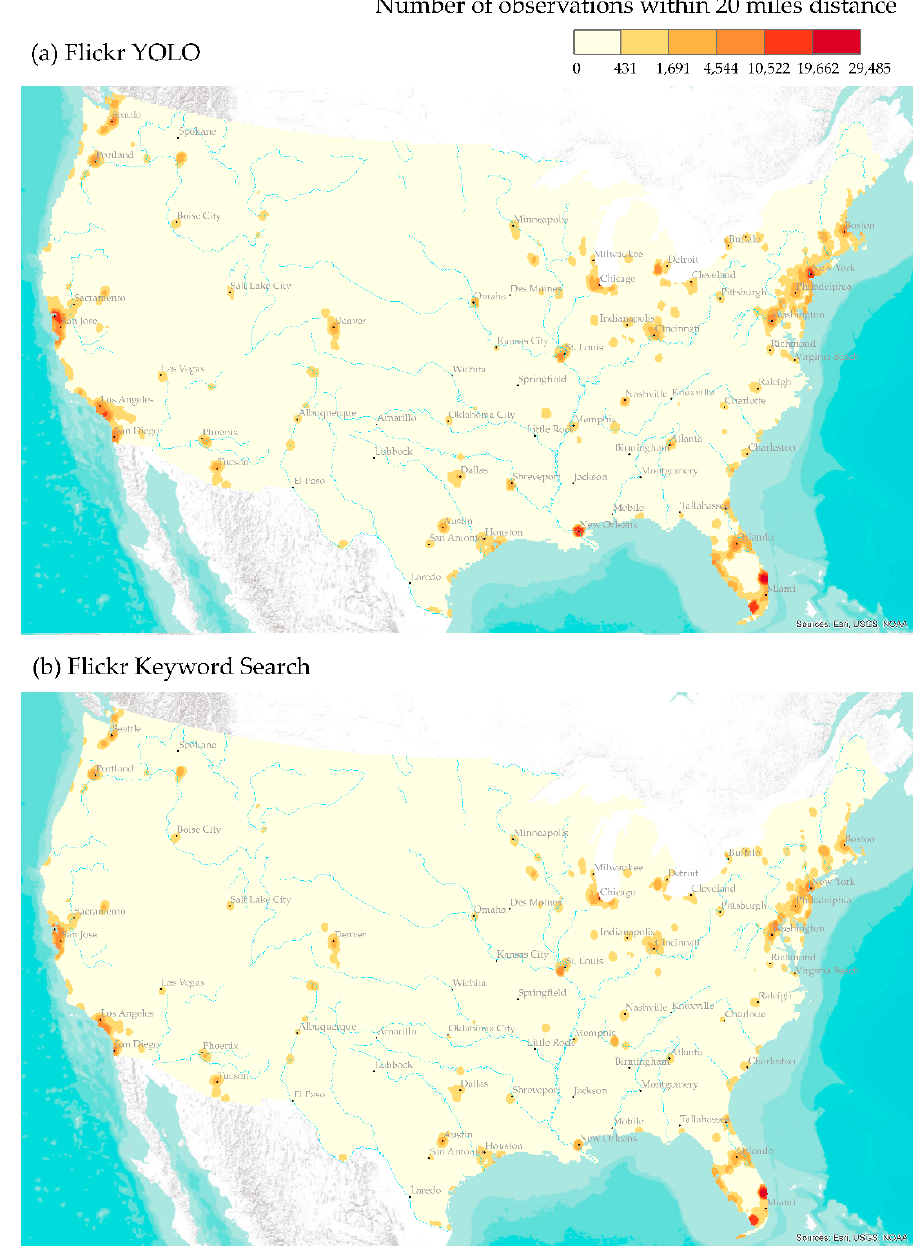
Figure 6. Fixed-distance (20 miles) density of ( a ) YOLO-detected and ( b ) keyword search Flickr bird image counts.